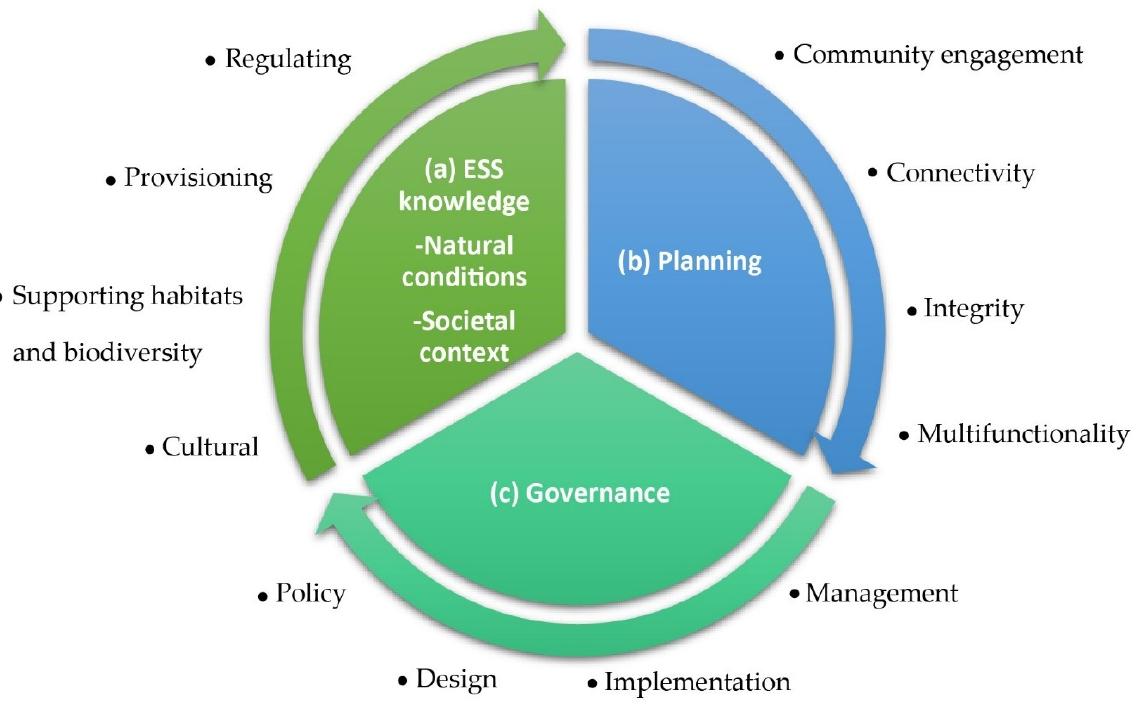
Figure 2. The framework of the study. Source: Authors.